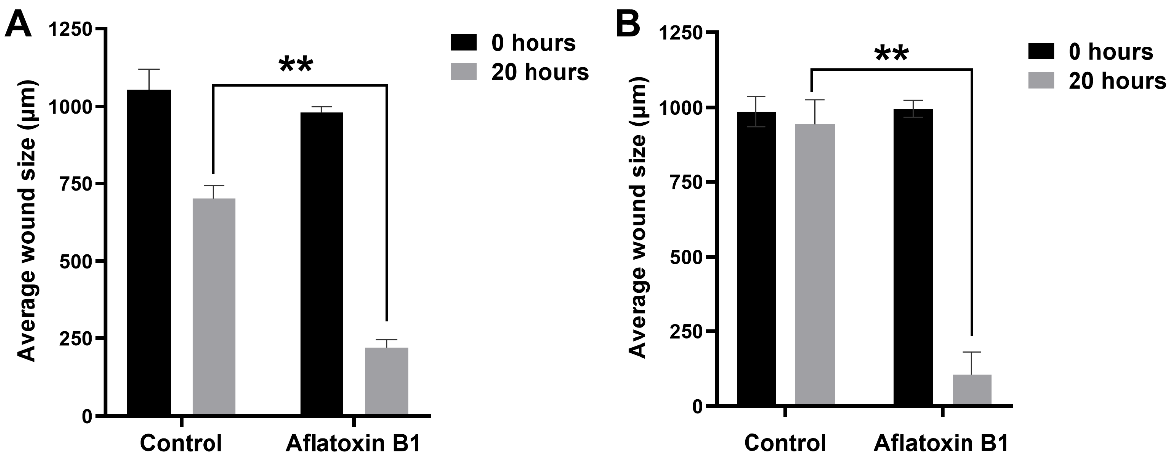
Figure 6. The effects of aflatoxin B1 on cell migration of MCF7 ( A ) and MCF10A ( B ) cells. ** p < 0.01 as compared to